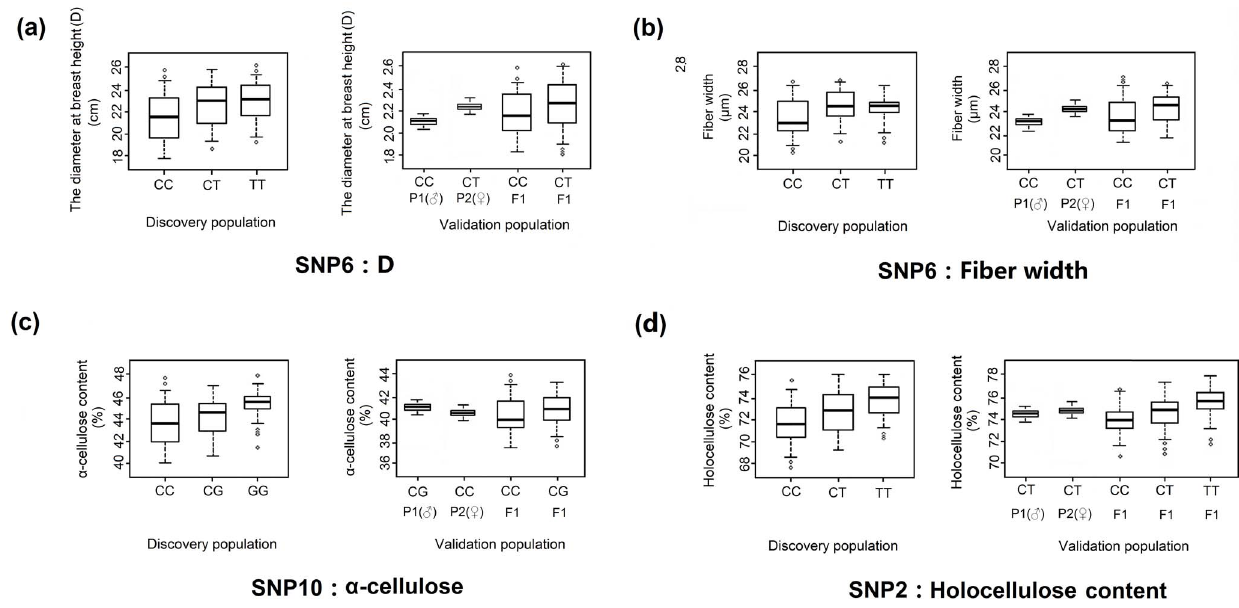
Figure 5. Genotypic effect on the significant single nucleotide polymorphisms (SNPs) found in PtUXS1 with the same phenotypic trait in discovery and validation populations. (a–b) The nonsynonymous marker (SNP6) in exon1 of PtUXS1 significantly associated with fiber width and D in discovery and validation populations, and shows patterns of gene action consistent with dominant effects. The T allele at SNP6 causes a Tyr to His amino acid substitution. (c) SNP10 in exon 1, a synonymous mutation, was associated with a -cellulose content in both populations, illustrating the pattern of gene action consistent with additive effects. (d) SNP2 from the 5 9 UTR of PtUXS1 showed significant association with holocellulose content in both populations. The differences in holocellulose content among the three genotypes of this marker indicate that patterns of gene action are consistent with additive effects.